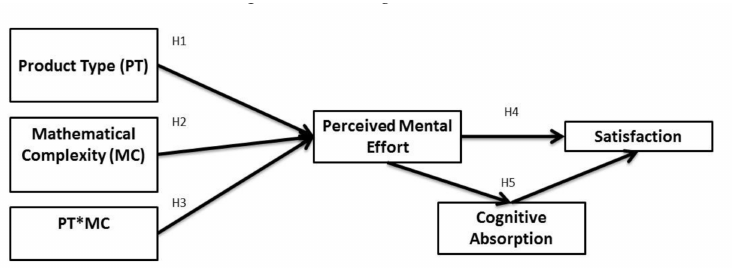
Figure 1. Research